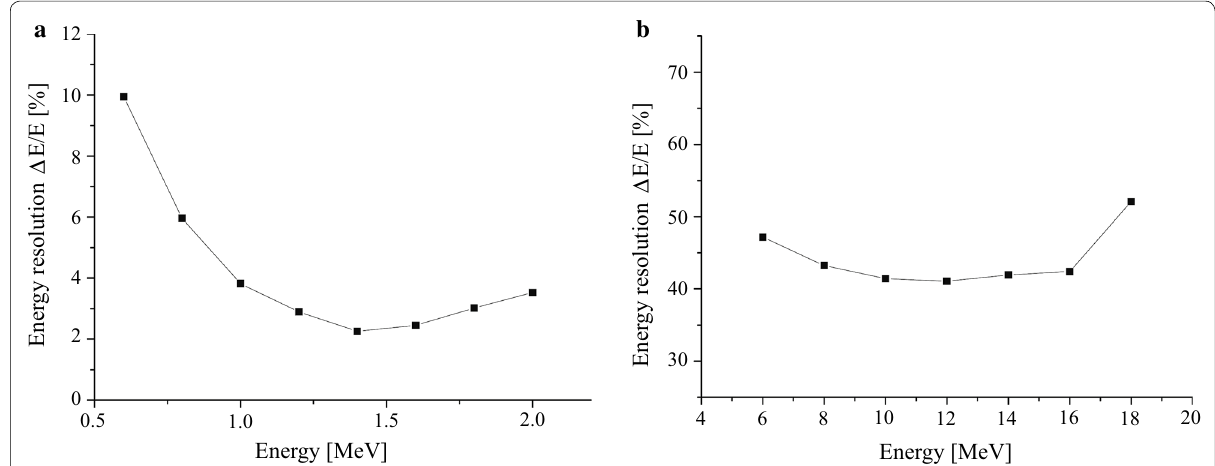
Fig. 8 The energy resolution evaluated by the irradiation tests: a the irradiation test of 0.6–2 MeV electrons at TKSC and b the irradiation test of